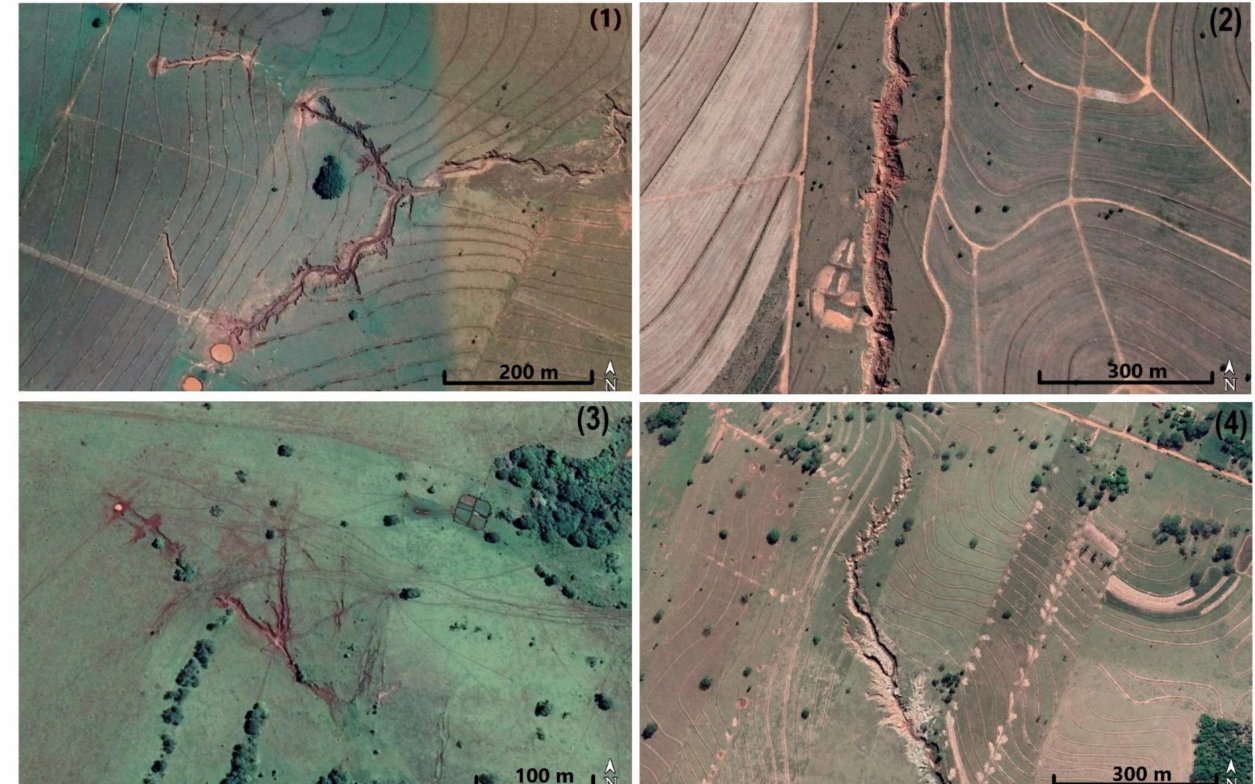
Figure 2. Examples of gully erosion. See Figure 1 for their location in the Ivinhema